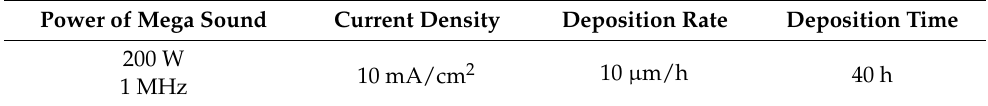
Table 4. Copper electroforming parameters.